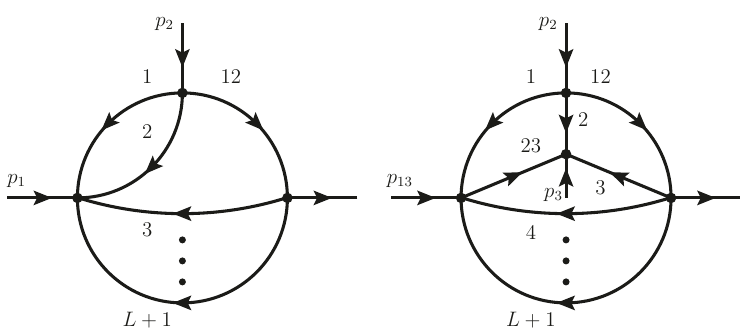
Figure 6 . Next-to-Maximal Loop Topology (left) and Next-to-Next-to-Maximal Loop Topology (right) at L loops with the insertion of external momenta p i , according to eqs.